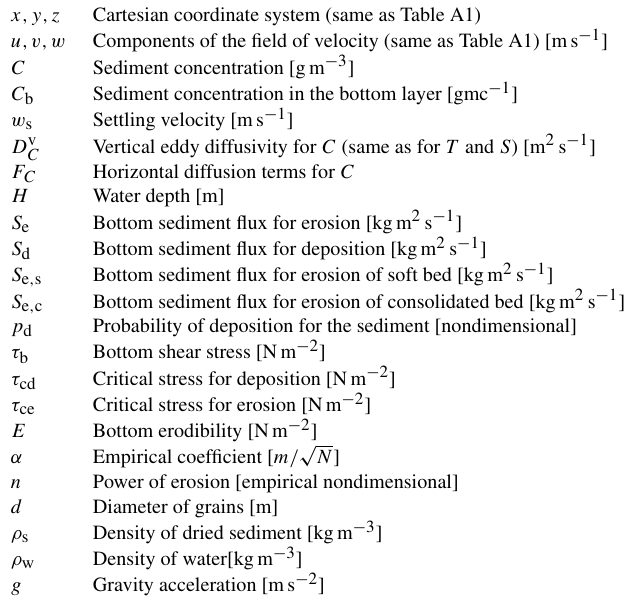
Table B1. Symbols used in Eq. (B1) to (B7) and the associated pa- rameterizations of the sediment transport